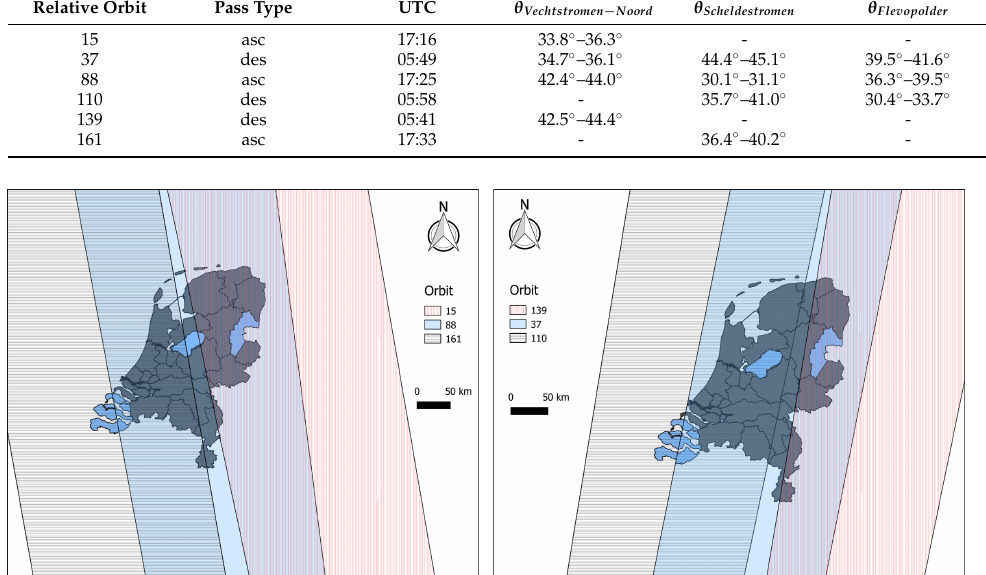
Figure 3. Sentinel-1 descending ( left ) and ascending ( right ) passes and relative orbits covering the